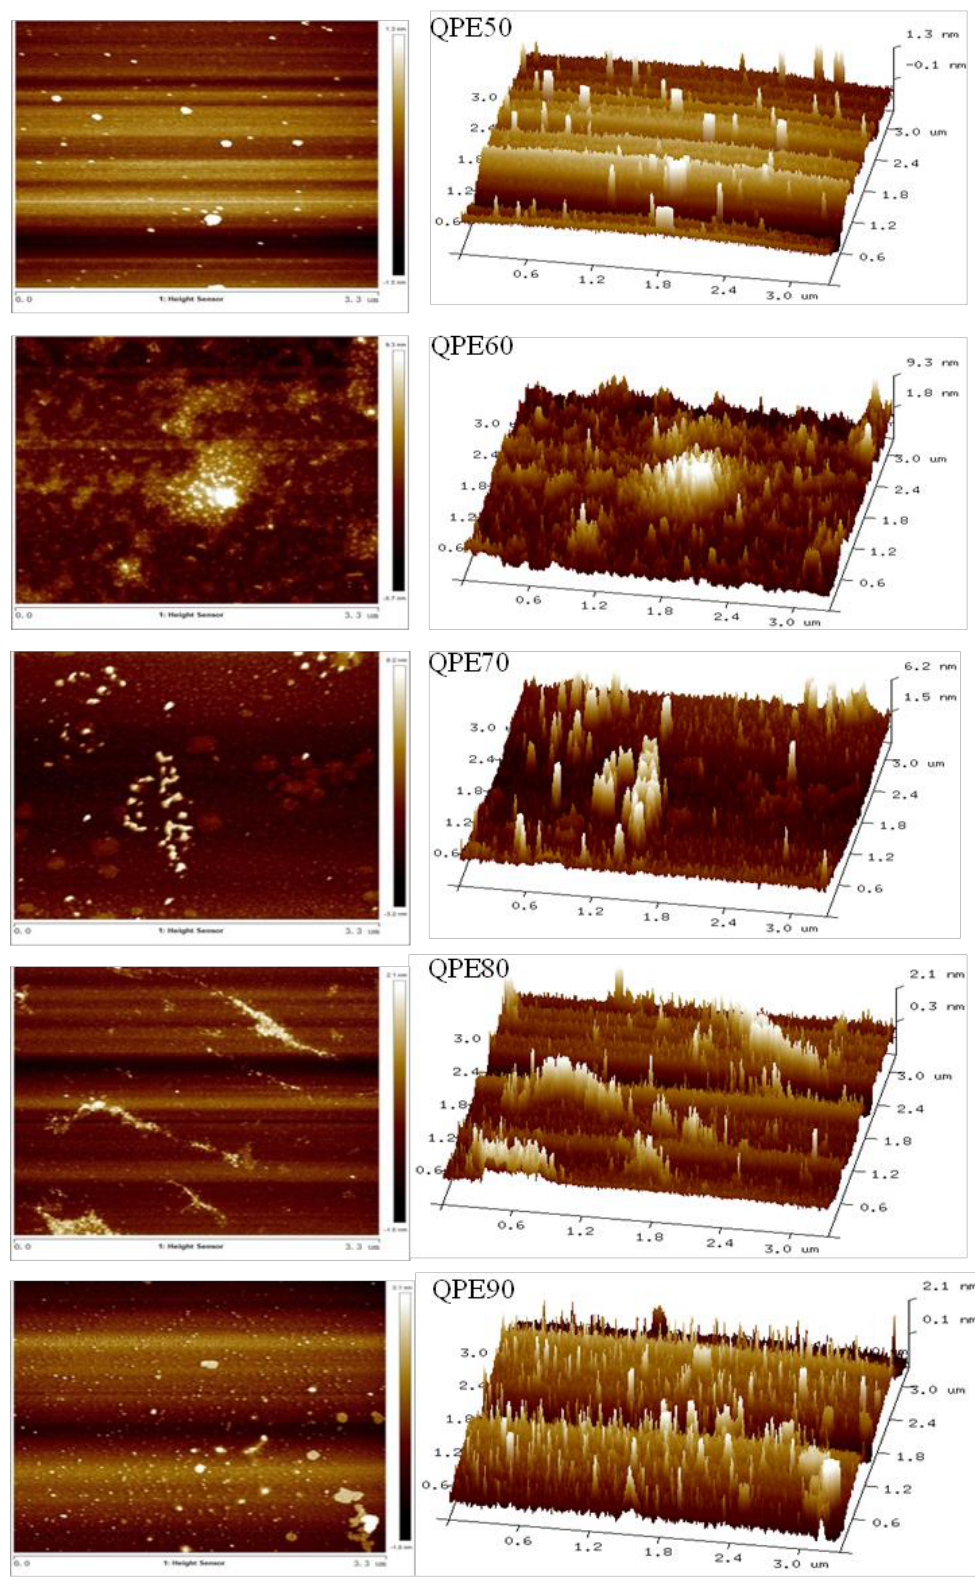
Figure 5. Atomic force microscope images (2D/3D) of QPs.